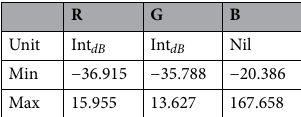
Table 4. Statistical summary of σ